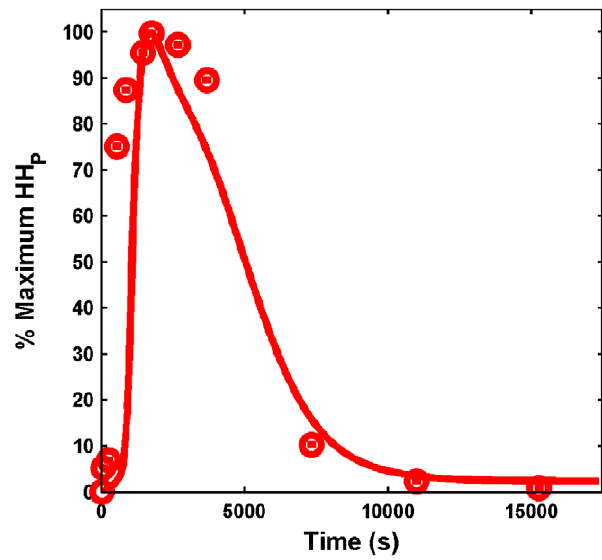
Figure 3. Fitted and experimental time series of the phosphor- ylated HH complex. Simulated mono-phosphorylated HH p (shown in continuous line) for k stress value of 0.9557, and the experimental data (shown in red circles) is taken from [25]. The percent conversion of the Y | 100 , for all the dynamical variables, time series is calculated as Y max and Y is the simulated time series.